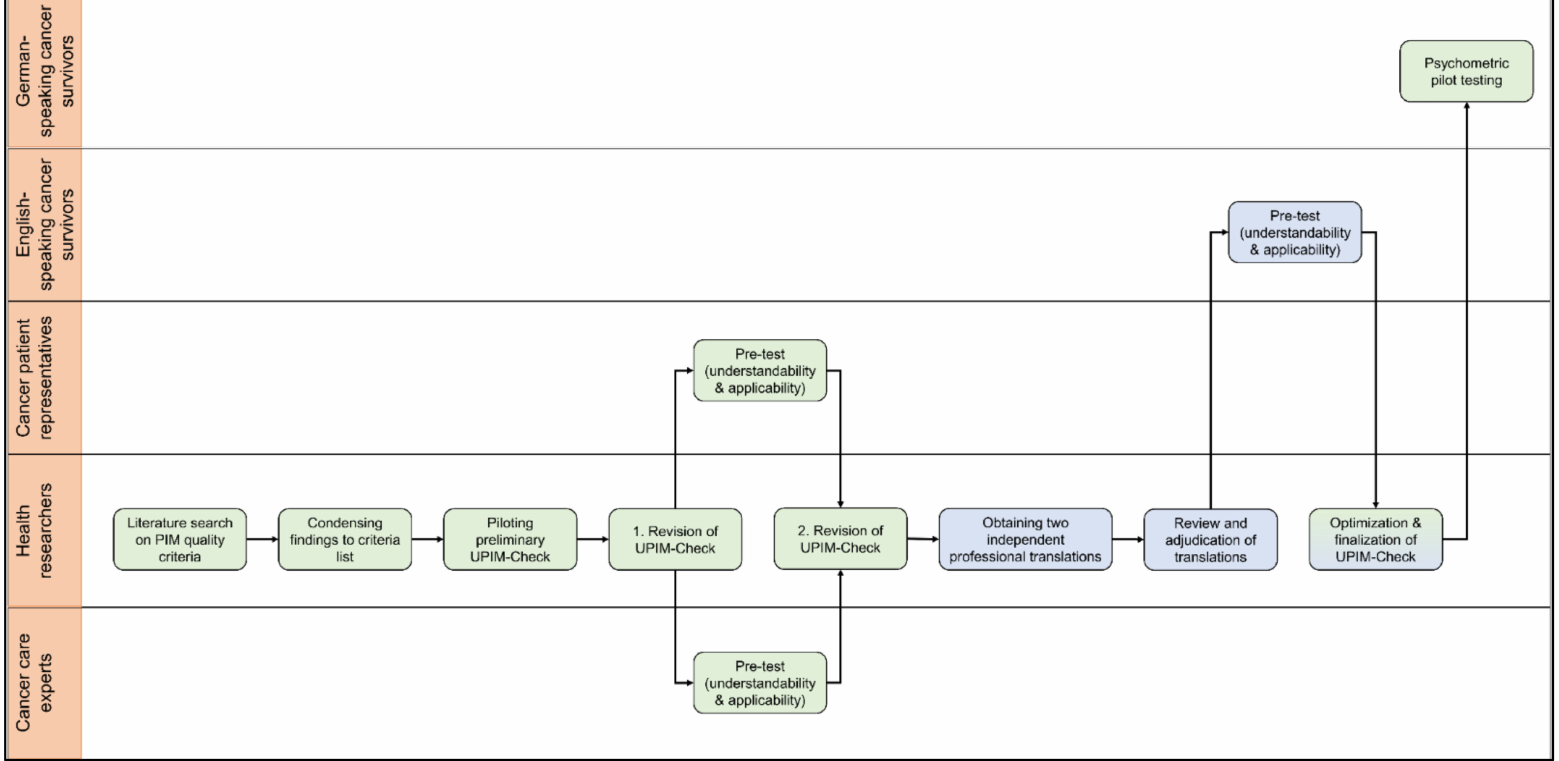
Figure 2. Process of the UPIM-Check development, translation, and psychometric pilot study. The steps are assigned to the group who facilitated and/or conducted this action. Steps in green represent the UPIM-Check German version, steps in blue represent the UPIM-Check English